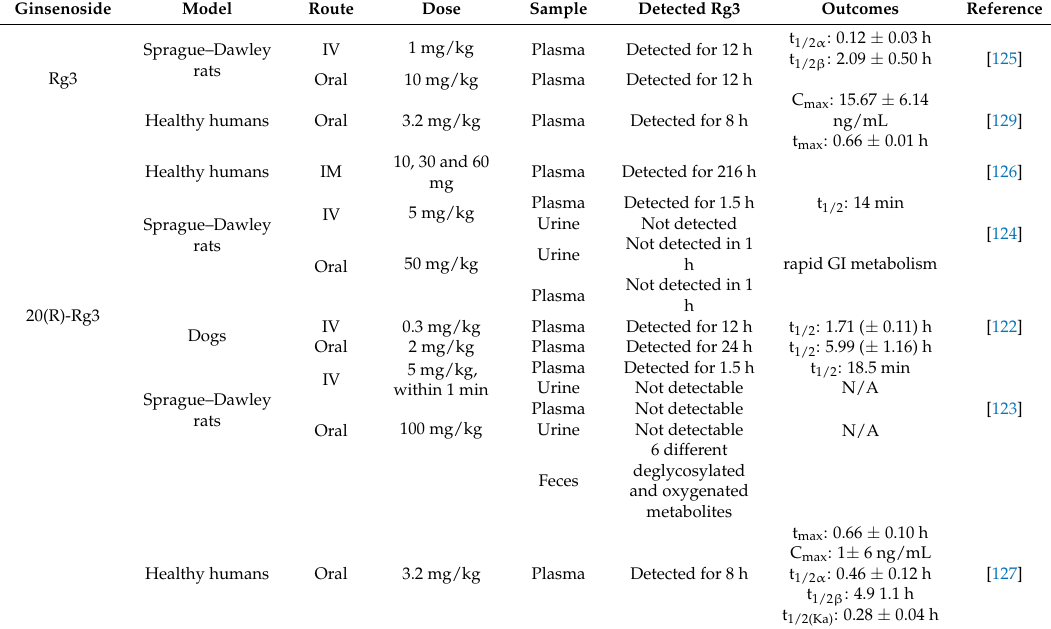
Table 4. A summary of the studies on the pharmacokinetics of Rg3 and the 20(R) epimer in in vivo